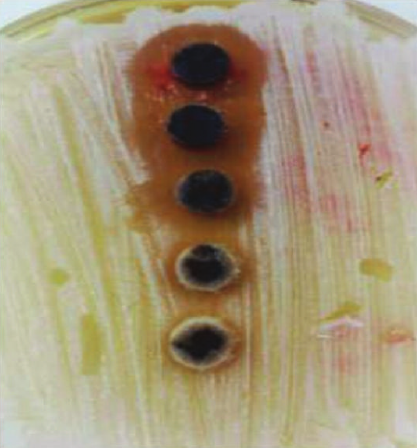
Figure 1: The effects of ethanolic extracts of juglans regia bark against S. salivarius